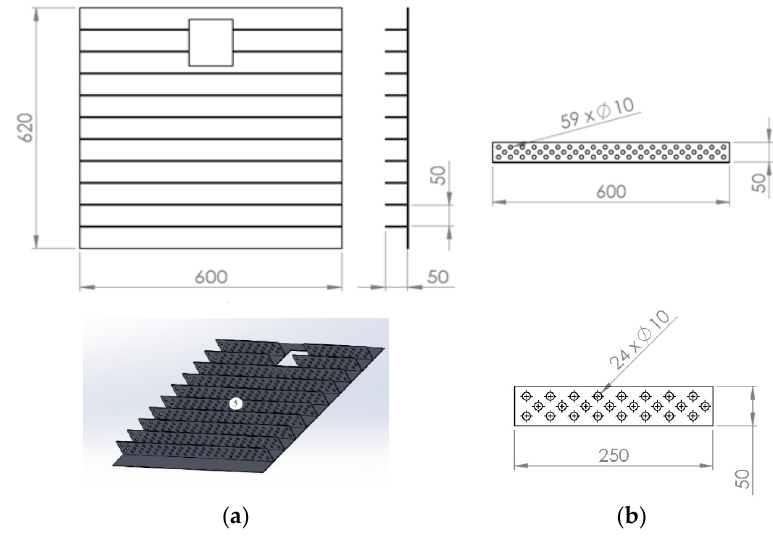
Figure 1. Dimension of ( a ) heat sink, ( b ) fin.